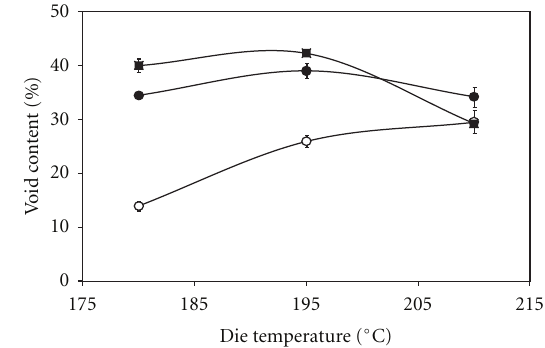
Figure 4: Evolution of the void content as a function of the die temperature and screw speed ( (cid:2) : 10 rpm, (cid:3) : 20 rpm, (cid:2) : 30rpm) (PLA 7000D; 2 wt% CBA1; temperature profile A; free